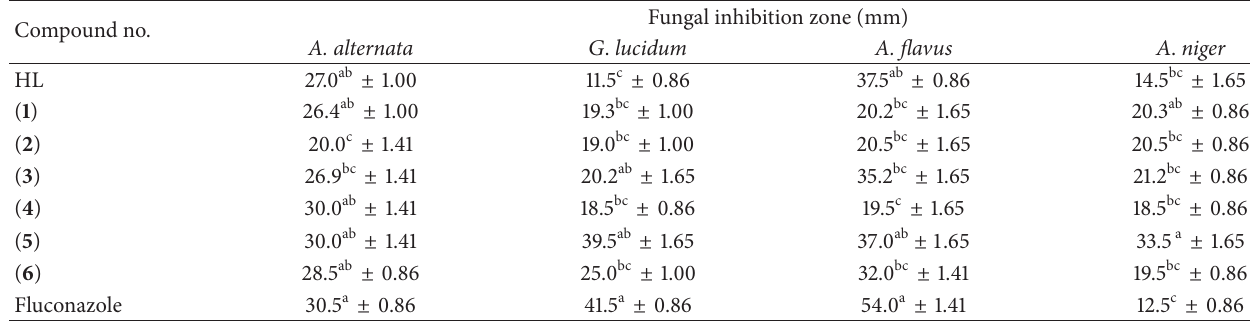
Fungal inhibition zone